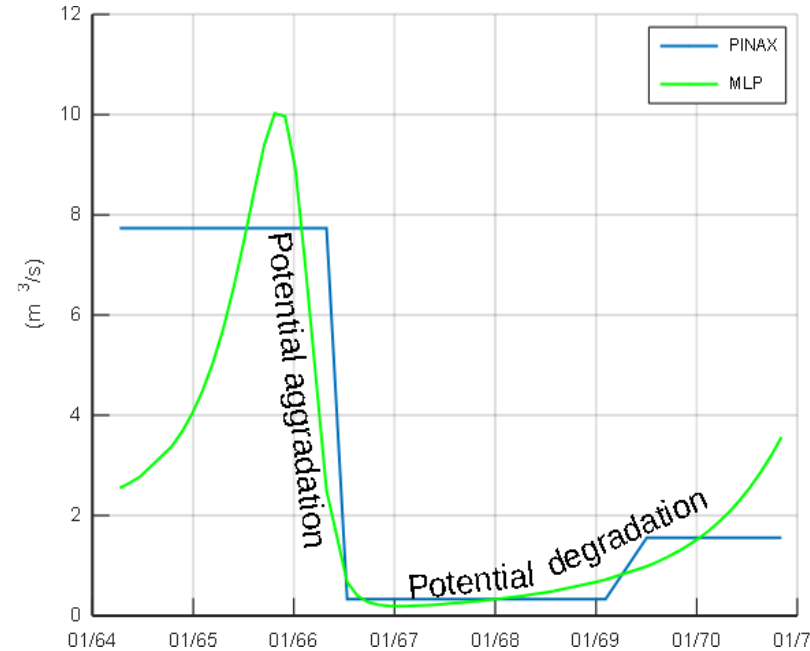
Figure 8. Sakoulevas case study—discharge over time corresponding to a constant stage (equal to mean observed stage) as it is calculated by the 3 PINAX-obtained regressions and the MLP.